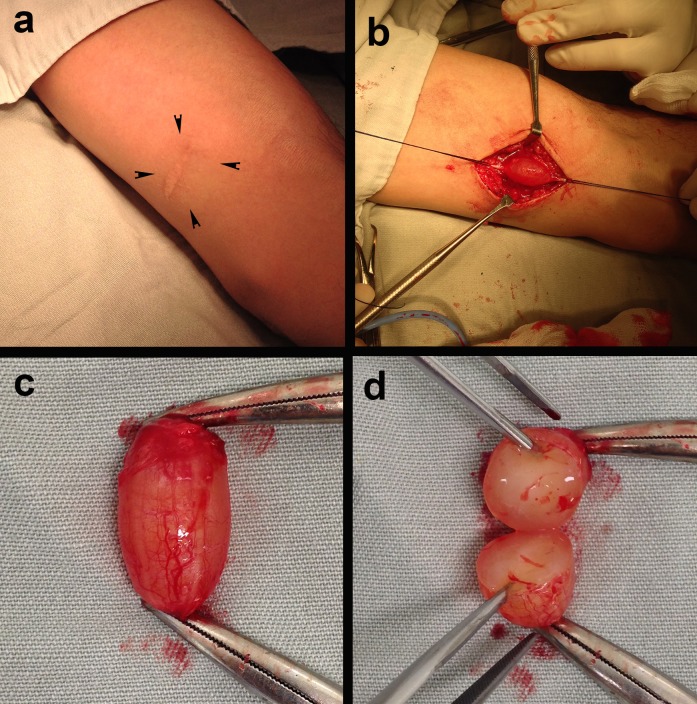
Images showing the preoperative appearance (a); the cystic lesion dissected and firmly adhering to the basilic vein, which was repaired with cotton thread (b); the resected lesion (c); and the lesion sectioned, showing its content (d).